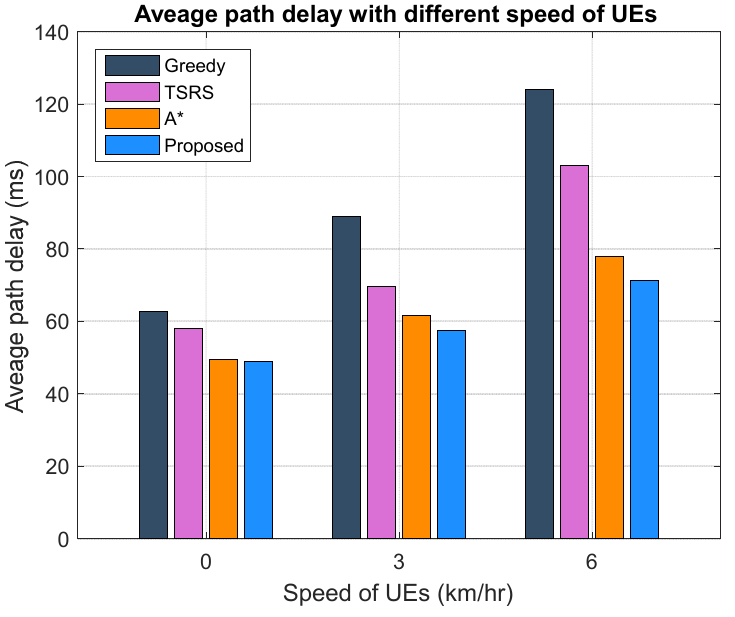
Figure 15. Delay vs. UE’s moving speed.